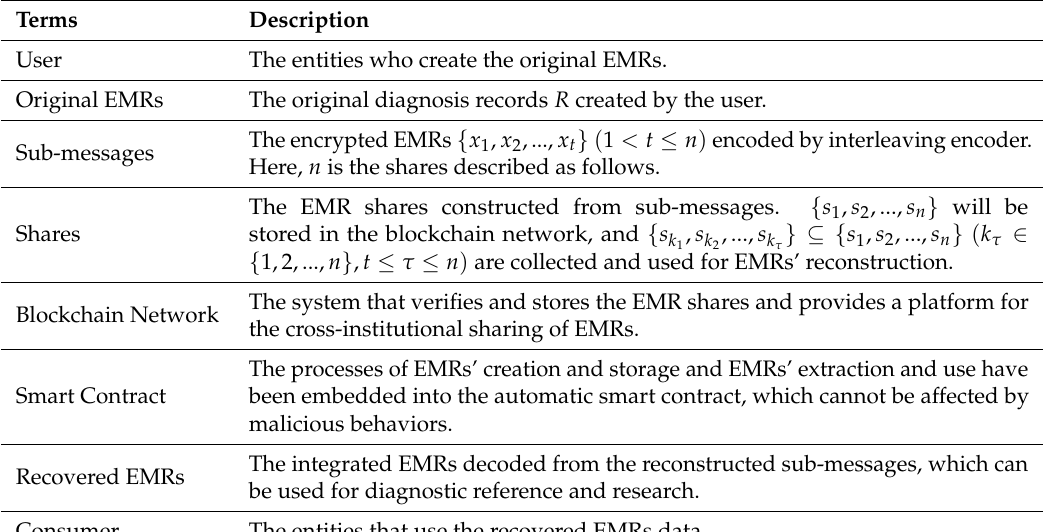
Table 1. Main terms of the lightweight privacy-preserving